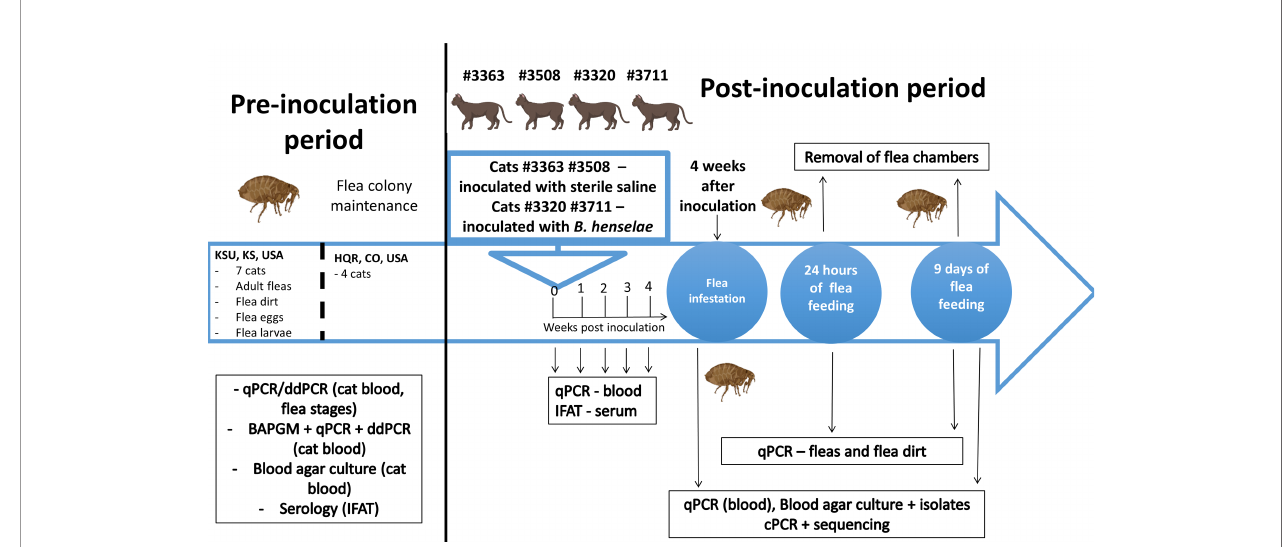
FIGURE 1 | Schematic timeline of the fl ea proteomic experimental study. Created with